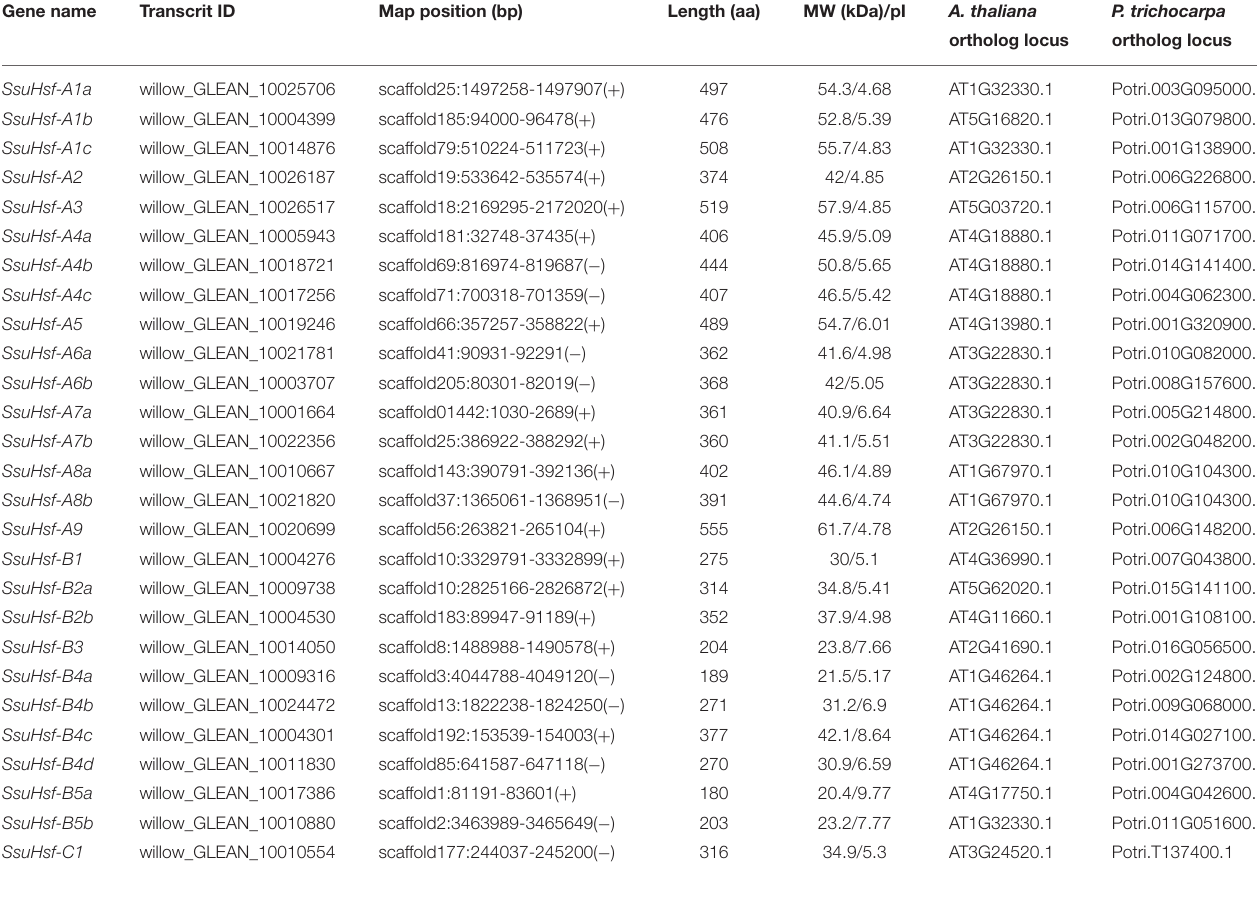
TABLE 1 | The Hsf genes identified from the S. suchowensis